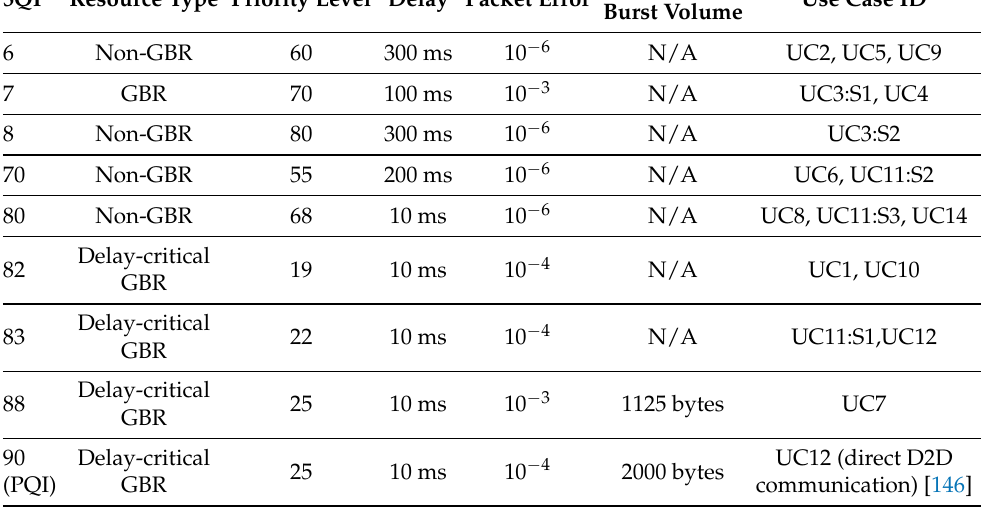
Table 5. 3GPP 5QIs [117] and PQI [146] supporting the analyzed use